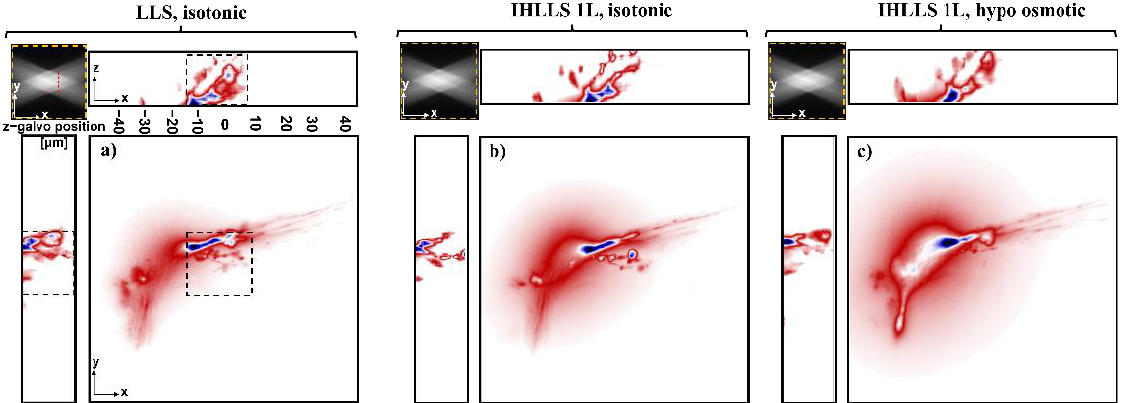
Figure 3. Tomographic imaging of a lamprey spinal cord ventral horn neuron with dendrites, xy FOV 208 × 208 µm 2 , 2048 × 2048 pixels, yz, (xz) FOV 208 × 40 µm 2 , 2048 × 400 pixels, in a conventional LLS ( a ) and incoherent LLS with only one diffractive lens (IHLLS 1L) of focal length 400 mm without deconvolution; recordings were initially in isotonic solution ( b ), and then in hypotonic solution to cause swelling ( c ). On the sides and above are shown the max projections through the volume (400 z -galvo steps). The Bessel beams are displayed in the upper-left corner of each xy-projection to show the orientation of the beams ( FOV 208 µ m 2 ). The area enclosed inside the colored dashed rectangles are as follows: black—the scanning area for the original LLS (52 µ m 2 ), and yellow—the actual scanning area for the LLS, IHLLS 1L, and IHLLS 2L. To expand the neurons as an initial test of the ability of the IHLLS system to record small changes in size, we repeated the experiment using the IHLLS 1L, where the Ringer’s solution was modified with hypotonic solution (225 mOsm) (Figure 3c). The third step